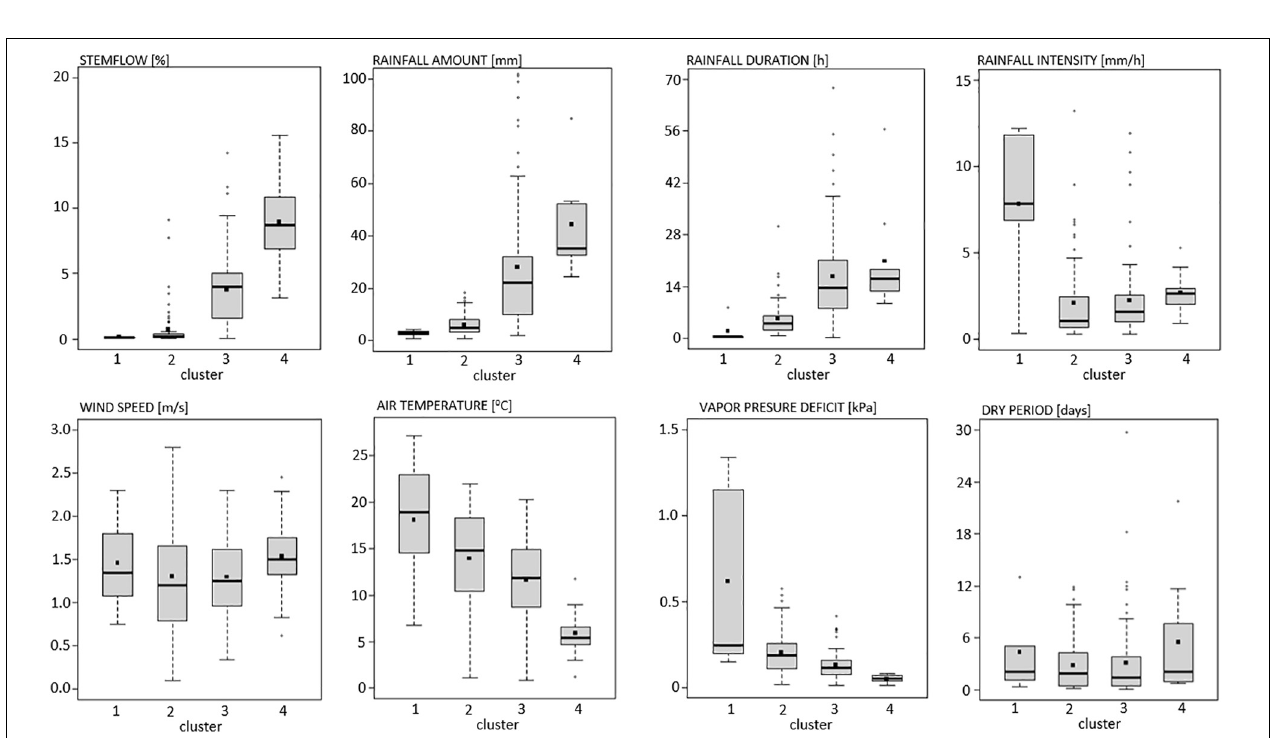
FIGURE 5 | Comparison of rain event characteristics for the events grouped in each cluster.